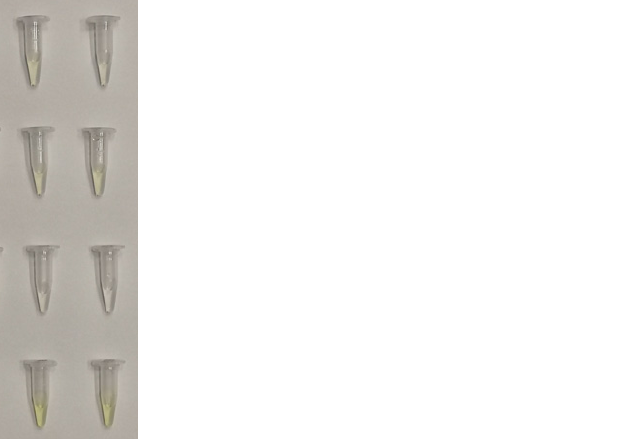
Figure 4. Successive samples (0.5 mL) collected after passing through BioGel P-150 : ( A ): TY-Ag, ( B ): BSA-TY, ( C ): BSA-TY-Ag, ( D ): TY.